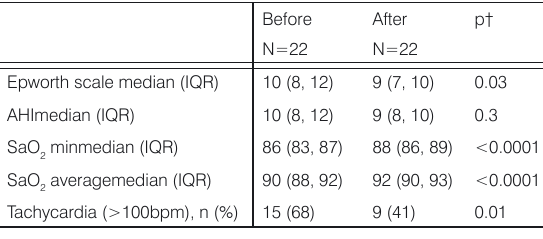
Table 1. Patients’ characteristic before and after twelve weeks administration of